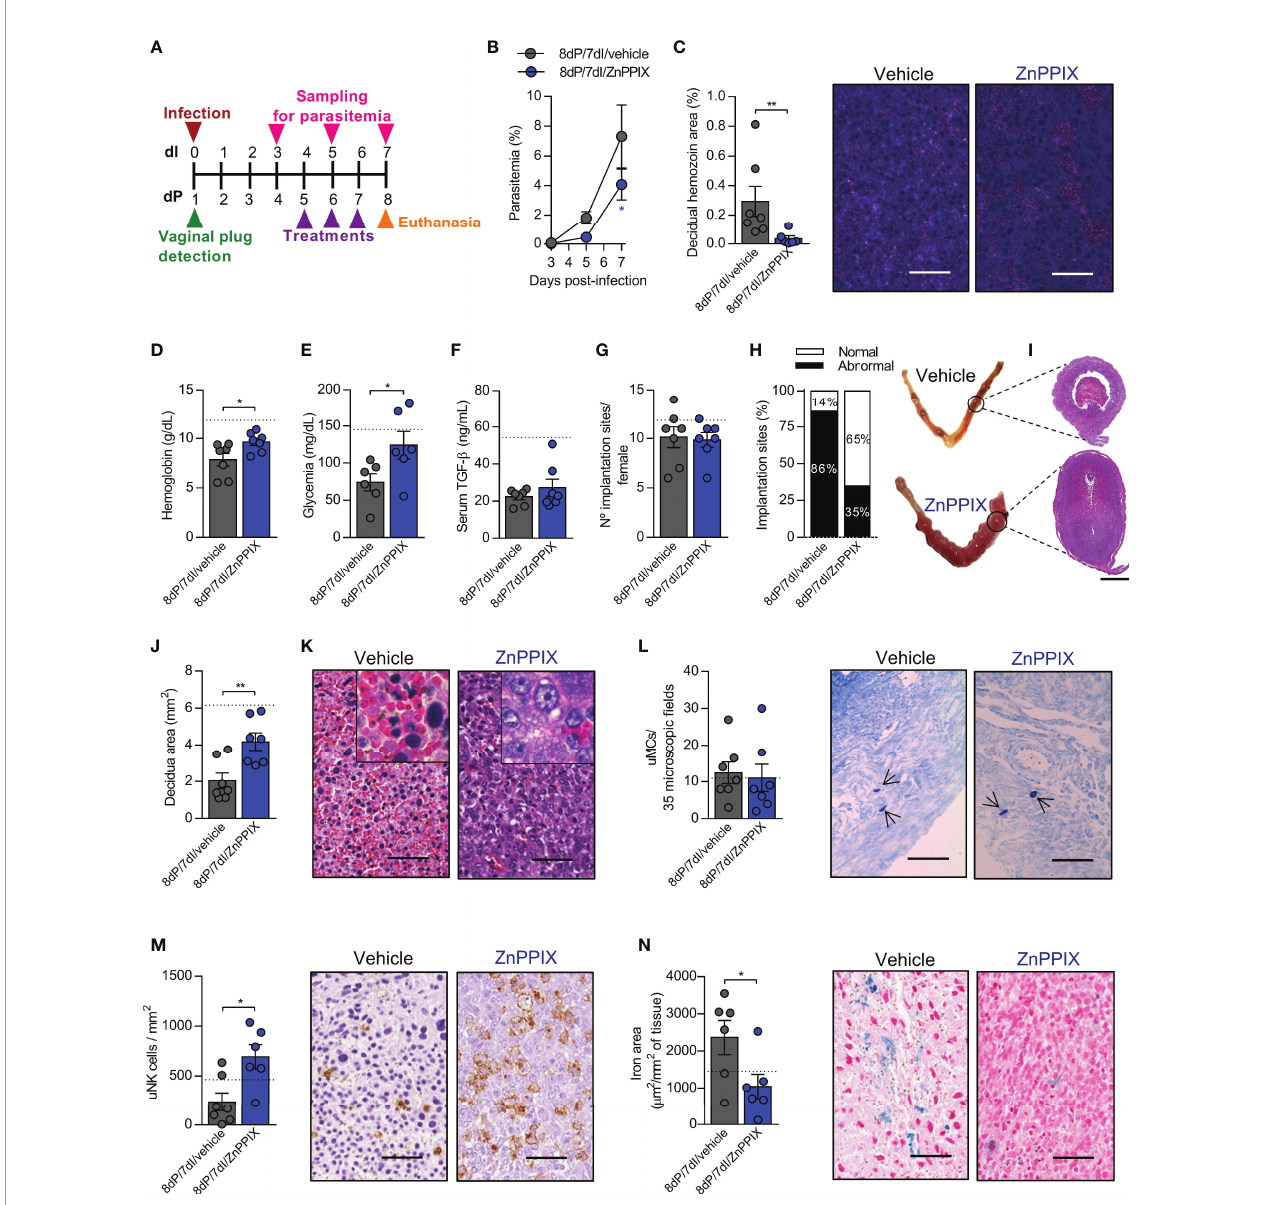
FIGURE 5 | Inhibition of HO-1 ameliorates the deleterious effects of malaria during early pregnancy. (A) An experimental design for the pharmacological inhibition of HO-1 by ZnPPIX during malaria in early gestation was performed. (B) Parasitemia levels were estimated by fl ow cytometry. Each symbol represents the mean of all animals within the indicated group ± SEM. (C) Hemozoin was detected in decidual tissue using polarized light microscopy, scale bar 50 m m. (D – F) Hemoglobin, blood glucose and serum TGF- b levels were measured. (G, H) The number of implantations sites per female was counted (G) and classi fi ed as normal or abnormal according to macroscopic aspect (H) (n = 7 mice/group). (I – K) Uterine tissue was histologically processed and tissue sections were stained by H&E (I) , scale bar 1 mm. Decidual area was delimited (J) and implantation sites alterations were evaluated (K) , scale bar 50 m m. (L) uMCs were detected and quanti fi ed in Toluidine Blue stained implantation sites, scale bar 50 m m. (M) uNK cells were detected and quanti fi ed in DBA lectin-stained implantation sites, scale bar 50 m m. (N) Quanti fi cation of iron deposition and representative images of iron-stained tissue, scale bar 50 m m. Unless otherwise stated, each symbol represents the measure of one mouse and results represent mean ± SEM (n= 6-7 mice/group). The dashed lines indicate the mean results of pregnant uninfected and untreated mice for each parameter evaluated. Data was analyzed by Two-way ANOVA followed by Bonferroni ’ s post-hoc comparisons tests (B) , unpaired t-test (D, E, G, J, L – N) or Mann-Whitney test (C, F, H) . NP, non-pregnant; NI, non-infected; dP, days of pregnancy; dI, days of infection. *: p <0.05; **: p